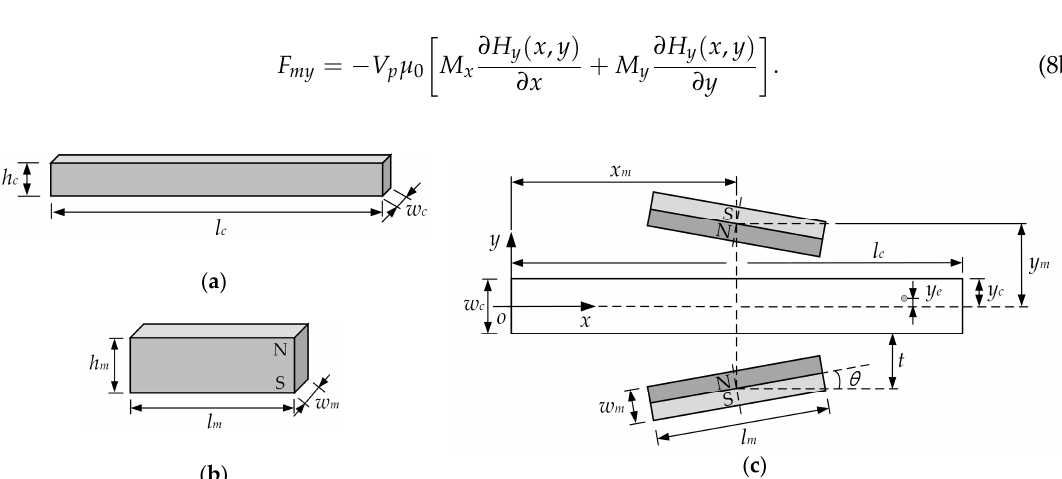
Figure 4. The dimensions of ( a ) the microfluidic channel and ( b ) the permanent magnets; ( c ) the relative locations of the microchannel and the magnets: l c = 50 mm, w c = 1 mm, h c = 1 mm, l m = 25 mm, w m = 3 mm, h m = 10 mm, t = 5.5 mm, x m = 25 mm, y m = 6 mm; x-y coordinate system is within the microchannel, with its origin at the center of the cross-section of the microchanel.